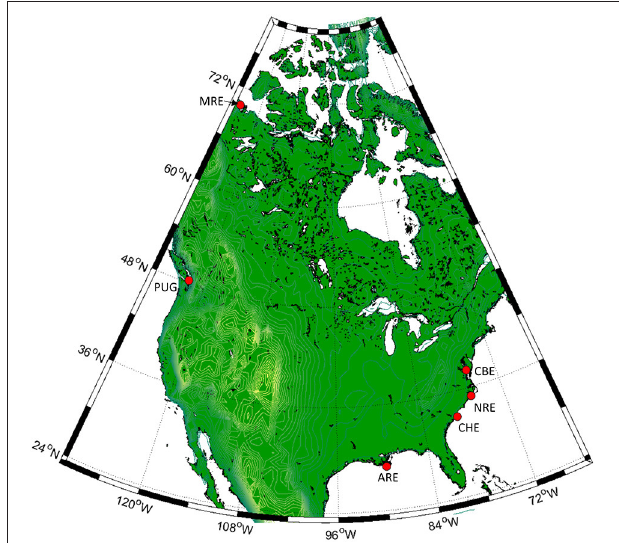
FIGURE 1 | Locations of the six North American estuaries in this study. Clockwise from right: Chesapeake Bay (CBE), Neuse River (NRE), Charleston Harbor (CHE), Atchafalaya River (ARE), Puget Sound (PUG), and Mackenzie River